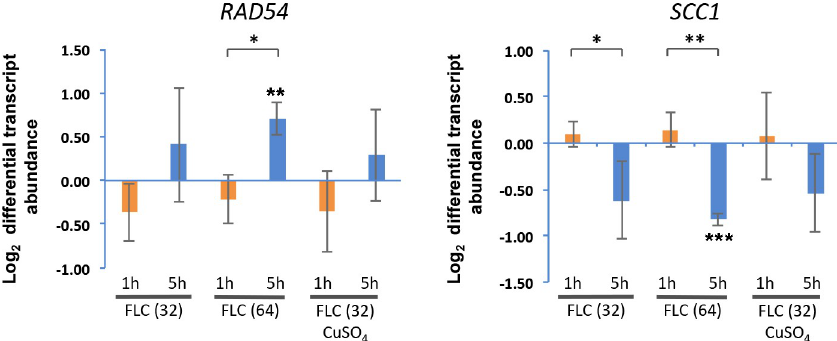
Fig 4. The effects of FLC on transcription of C . neoformans DNA repair genes ( RAD54 , and SCC1 ). Exponentially grown cultures of the C . neoformans (H99) were resuspended in YPD medium supplemented with FLC (32 or 64 μ